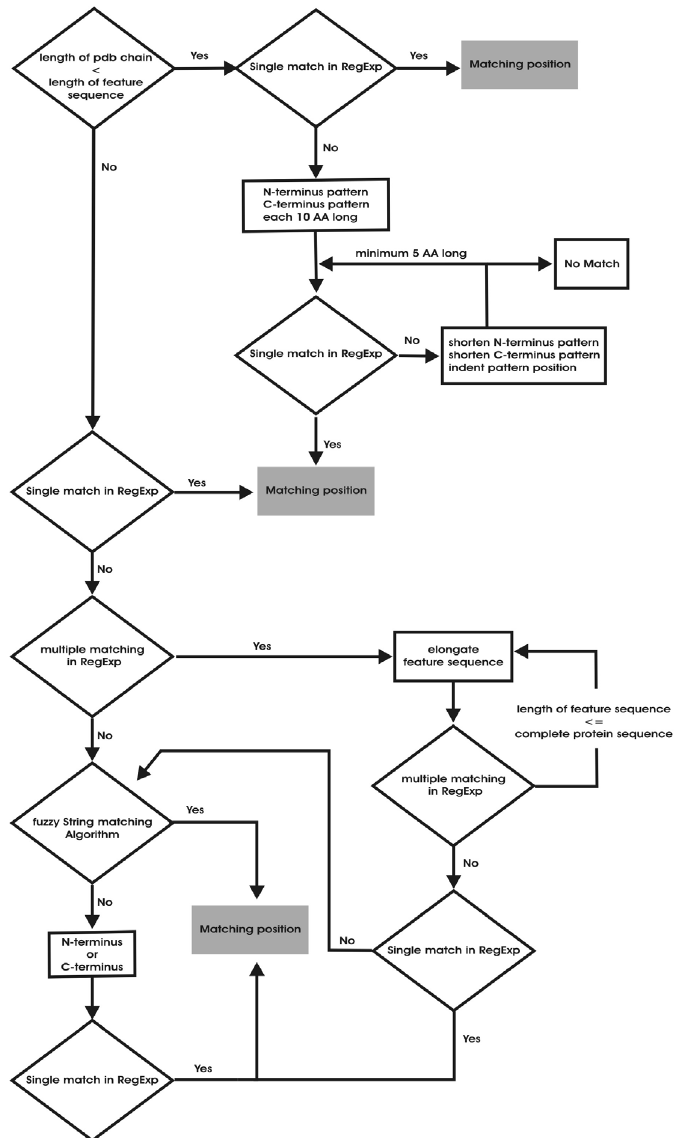
Fig. 2 Flow chart of the multi-way matching algorithm. The algorithm attempted to match a feature sequence from a SWISS-PROT entry with the corresponding chain sequence of a PDB entry. The rhombuses represent if-else statements (text in the middle of the rhombus). If loops were used, the break condition is shown at the corresponding arrow. The gray boxes indicate the unique matching of a feature sequence to a chain sequence of a PDB